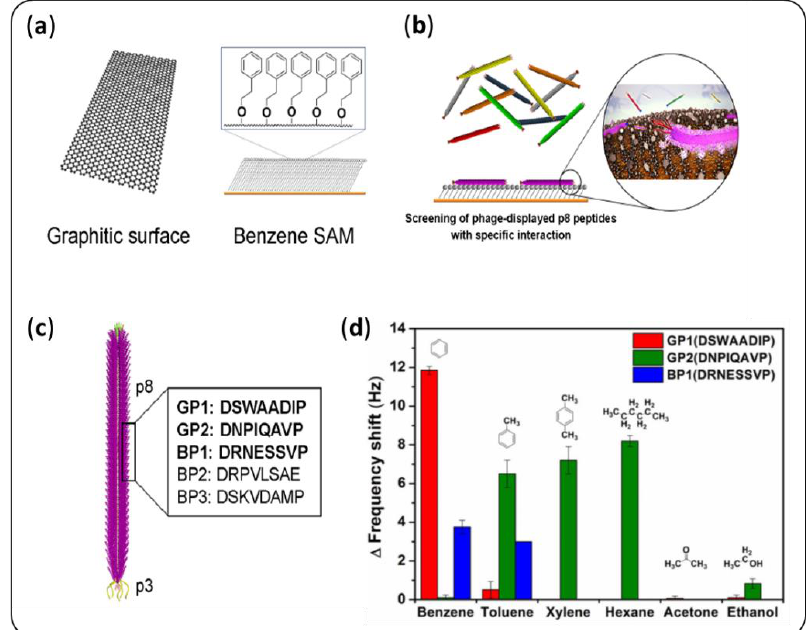
Figure 4. Example of a phage display protocol proposed by Ju et al. [79]. A library of M13 phages